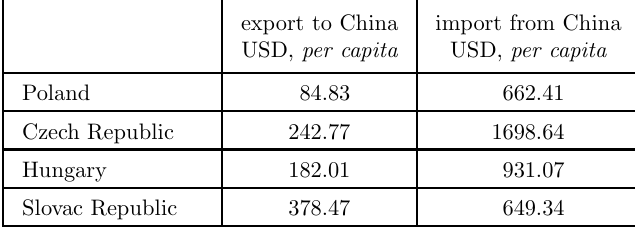
Export and import between V4 and China, USD, per capita, 2019 export to China import from China